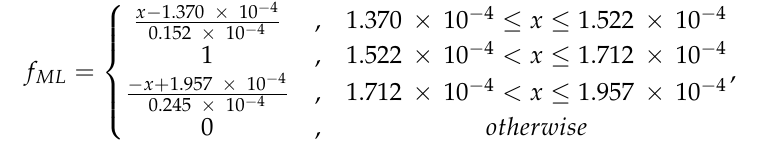
Table 1. Expert importance scoring rules.